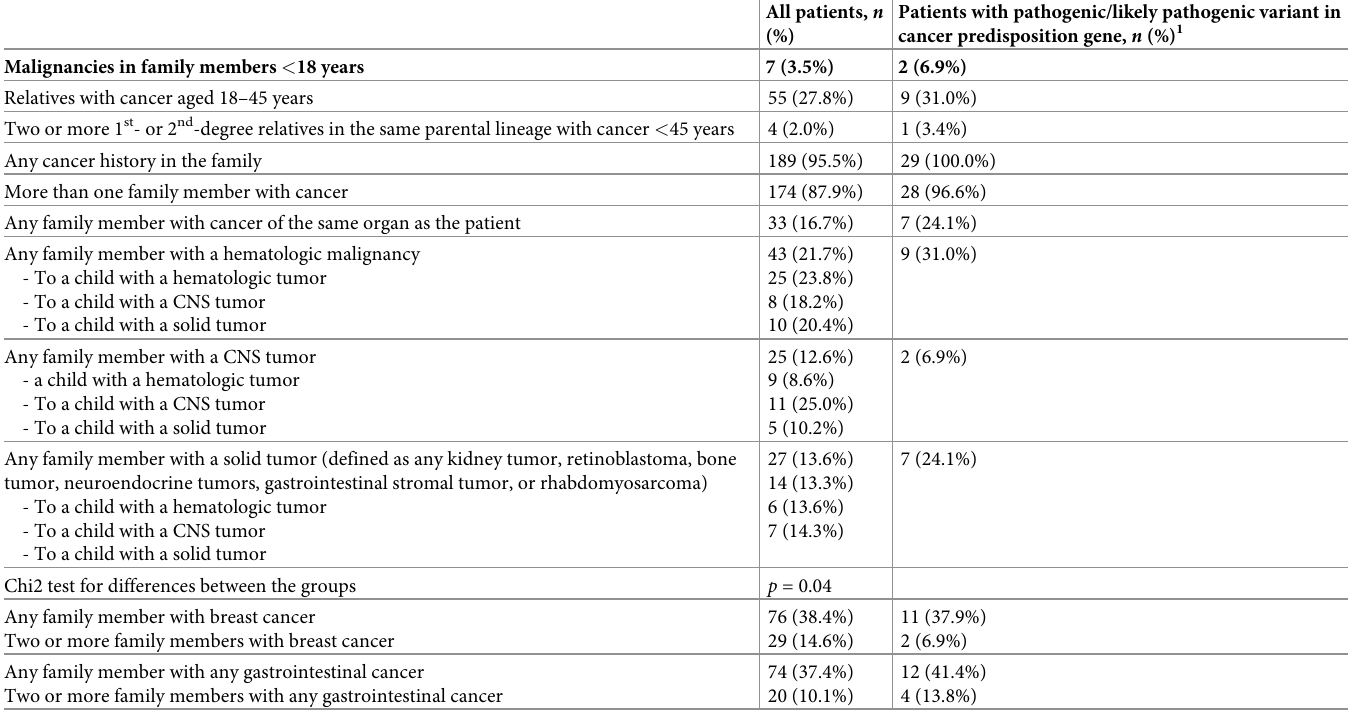
Table 10. Family pedigree findings for 1 st –3 rd degree relatives.